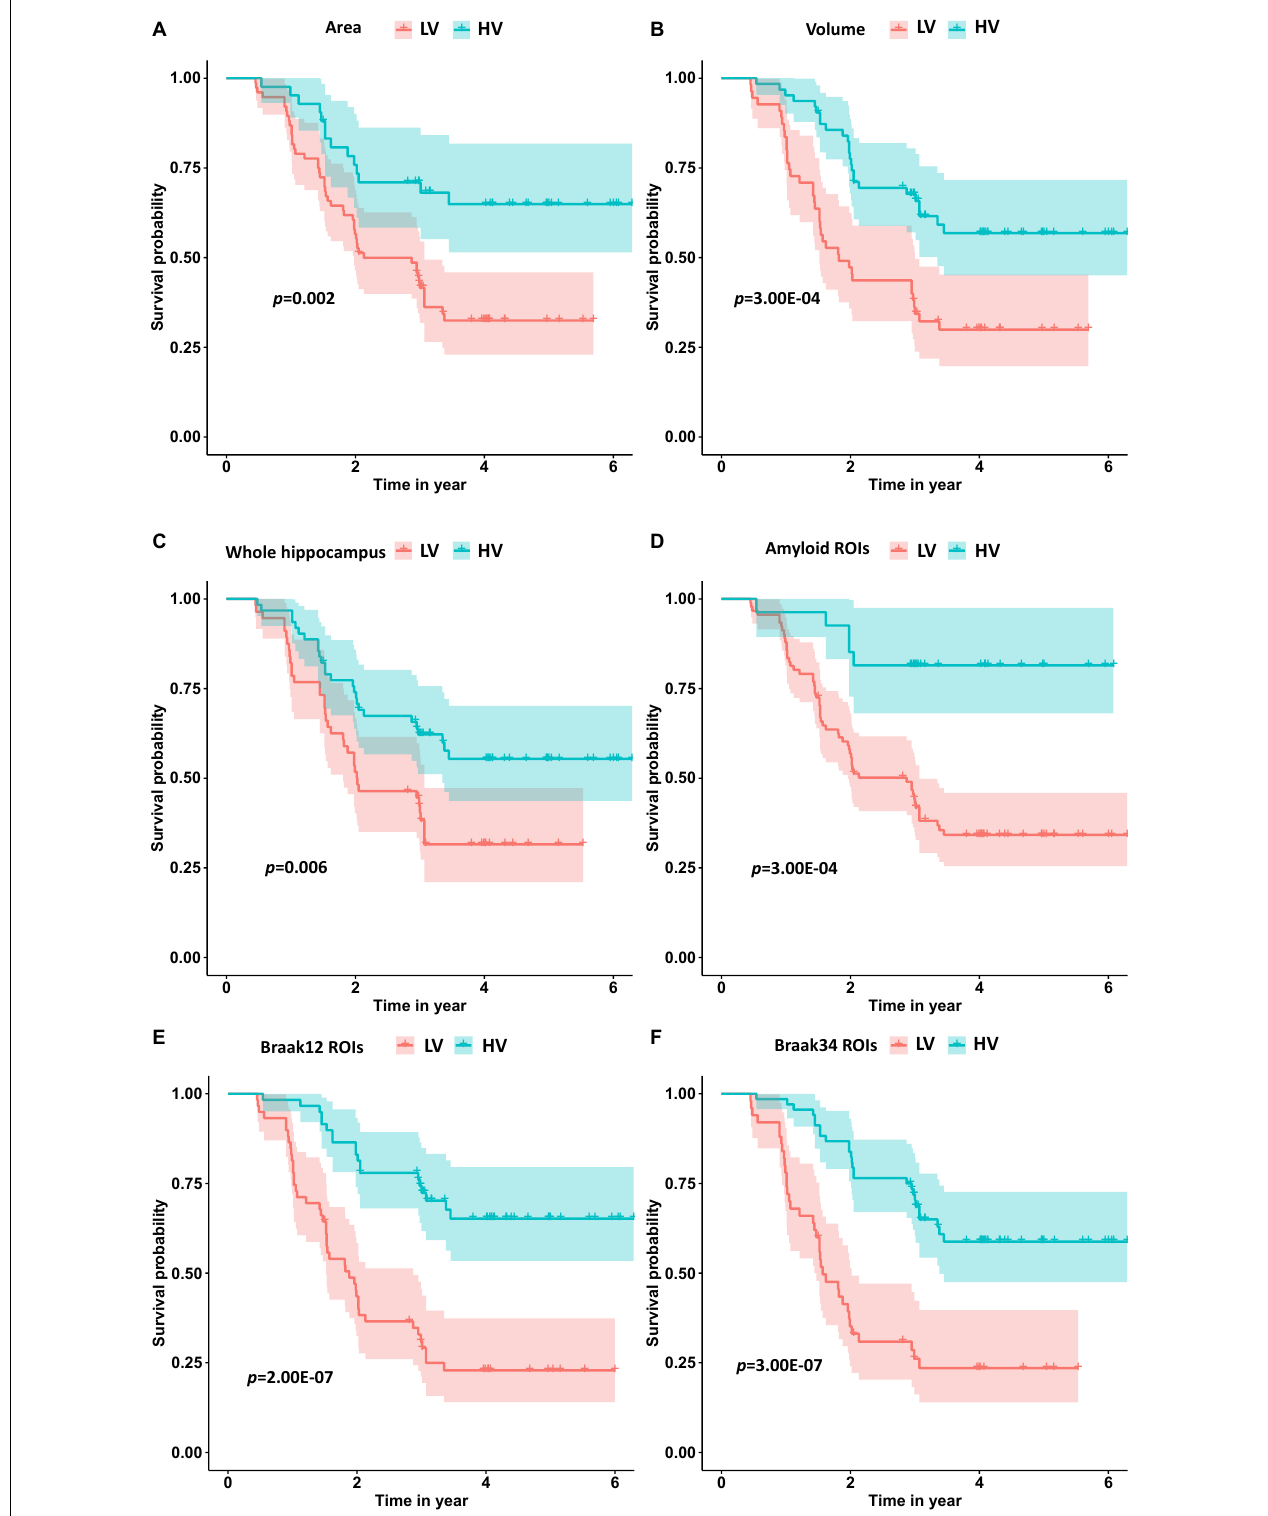
FIGURE 9 | The survival probability analysis for progression to AD in MCI patients based on hippocampal surface area (A) , volume (B) , the whole hippocampal features (C) , and the features on ROIs related to A β (D) , Braak12 (E) , and Braak34 (F) . The p-values are from the log-rank test. The red curve represents the high-value (HV) group for each measurement, and the blue one represents low-value (LV) group.